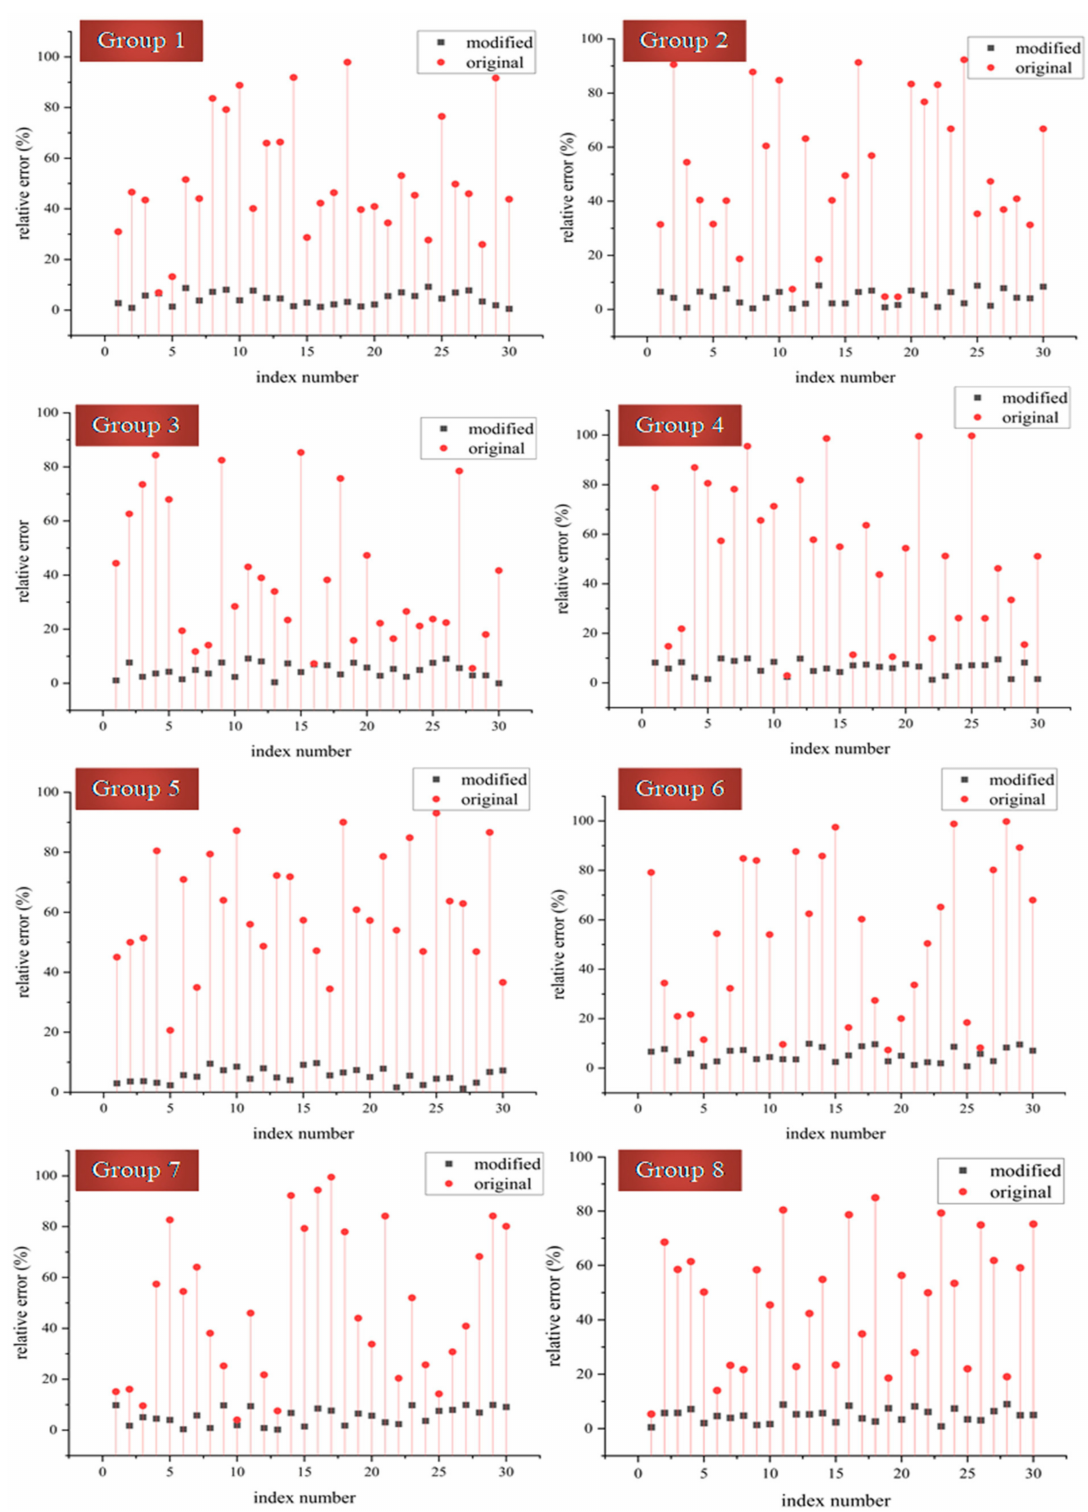
Figure 6. The comparison of model accuracy based on the data along the x